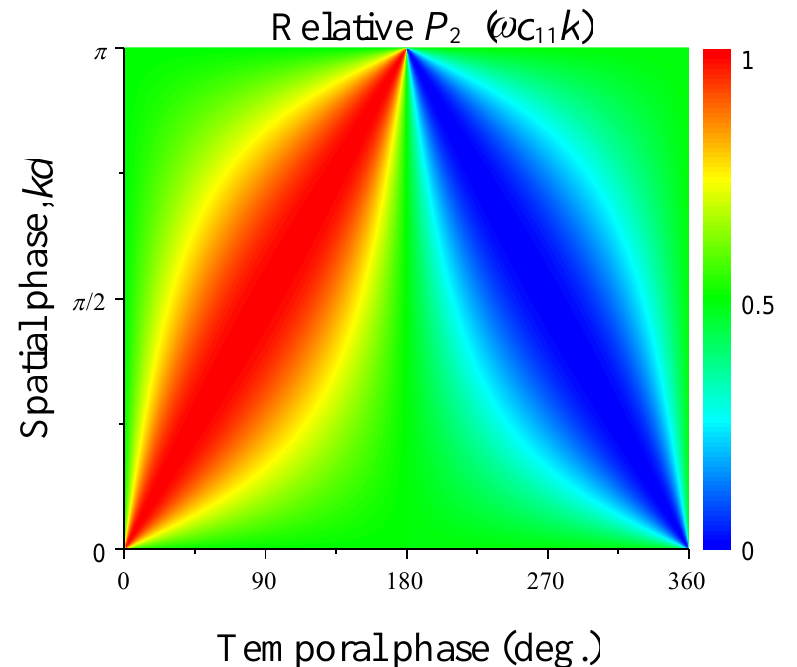
Figure 2. Relative output at port P 2 for two sources S 1 and S 2 , distant of d placed in a homogeneous nanobeam, at the wave vector k , as function of temporal and spatial phases.